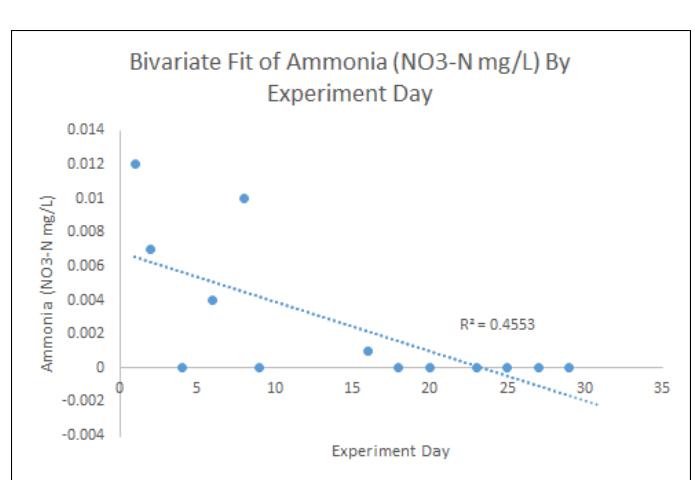
Figure 3. The correlation of ammonia to time shown in days.